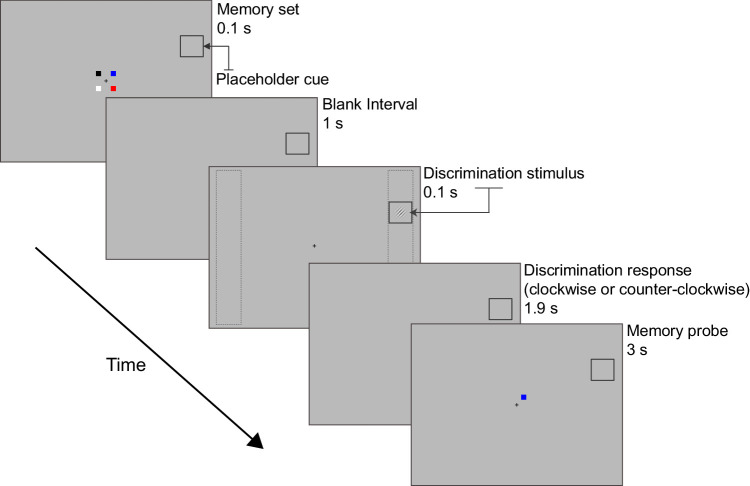
An example of a high VSTM load trial in the certain condition in Experiment 2. The procedure was identical to that of Experiment 1 except that a placeholder (see top right corner of the stimulus displays here) that indicated the spatial location of the Gabor patch was present throughout the duration of each trial. As in Experiment 1, the Gabor patch was presented inside a left or right columnar bar, shown here as gray dashed lines in the discrimination stimulus display but not presented during the experiment.